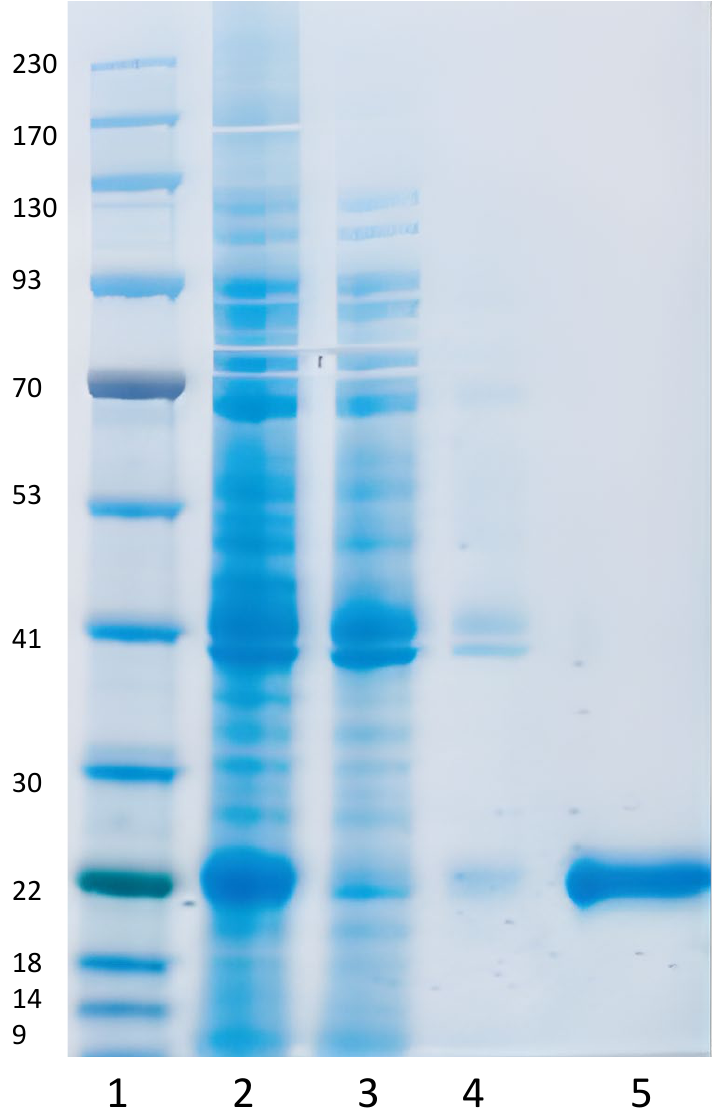
Figure 4. S1 333–527 RBD-C-tag vaccine antigen purification by affinity chromatography on a CaptureSelect TM C-tag affinity matrix (Thermo Fisher Scientific, Carlsbad, CA, USA). The representative gel shows SDS-PAGE with Coomassie Blue dye staining of proteins. Lane 1, MW protein markers; lane 2, EFT 90 h. fermentation supernatant, lane 3, fluid flow through; lane 4, wash fraction, lane 5 2.5 µg of purified eluted RBD C-tag antigen. The purified S1 333–527 RBD-C-tag vaccine antigen is marked with an arrow on the right.